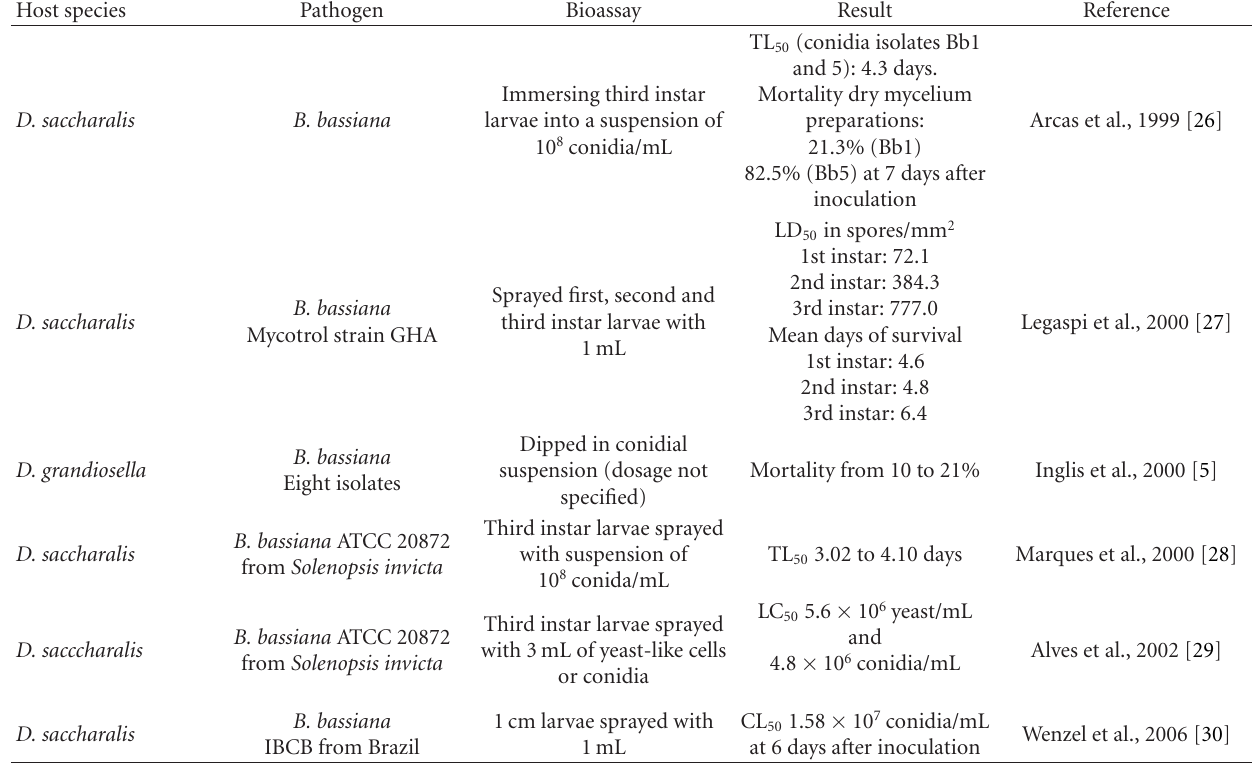
Table 2: Entomopathogenic-fungi bioassays on Diatraea spp.